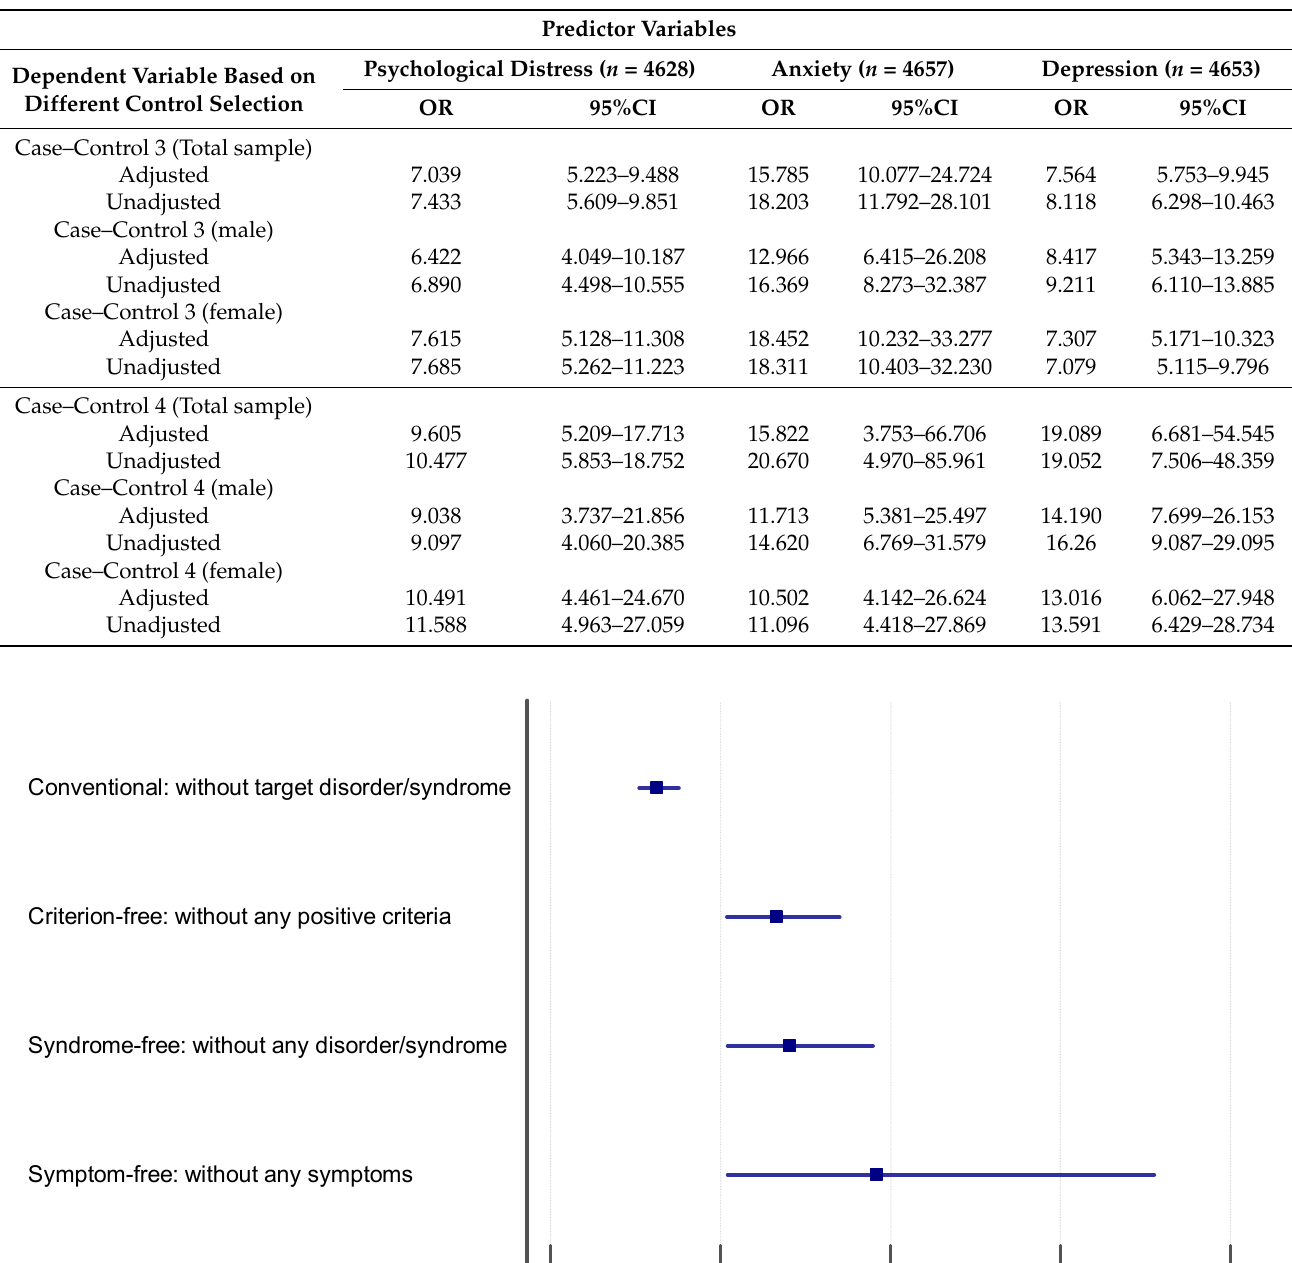
Figure 3. The estimated odds ratio for the association of anxiety and FD in each control group.